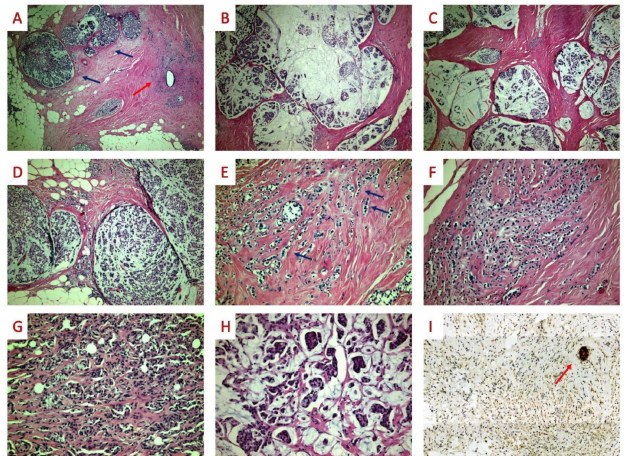
Figure 1. ILC with extracellular mucin production. (( A ) 40 × ): The tumor consists of a mucinous (blue arrows) and a non-mucinous (red arrow) component. (( B , C ) 40 × ): The mucinous component consists of multiple, relatively circumscribed, nodular foci of extracellular mucin. (( D ) 100 × ): On higher power, tumor cells are arranged as single cells, clusters, pseudocribriform structures, or solid nests. (( E , F ) 200 × ): The non- mucinous component shows typical ILC features such as a single-file pattern (blue arrows) and single cells lacking cohesion. (( G ) 200 × ): In both areas without (1( G )) and with extracellular mucin production (1( H )), intracellular mucin and signet-ring cells can be seen. (( I ) E-cadherin 200 × ) On immunohistochemistry, E-cadherin stain was negative; the red arrow points to positive internal